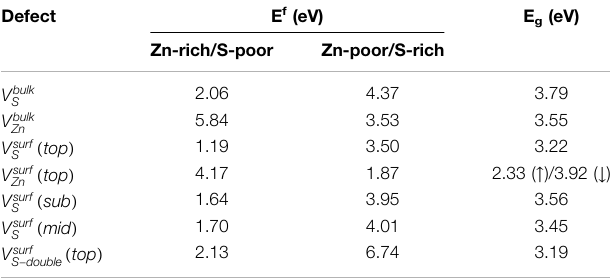
TABLE 2 | Calculated defect formation energies (E f ) together with the electronic band gap values (E g , estimated from singe particle Kohn-Sham eigenvalues) of sulphur and zinc vacancies present in the bulk as well as (220) surface of ZnS. The up (down) arrows represent spin up (down) states. All formation energies correspond to neutral defects and were obtained using